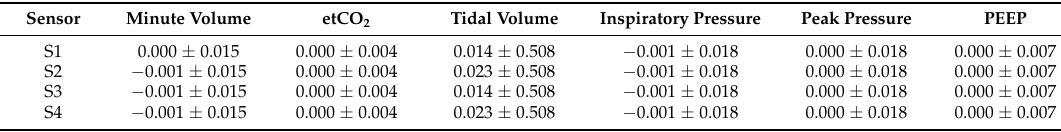
Table 4. Fixed effects regression coefficients of ventilation parameters vs. sensors after correction for ventilator settings and ETCO 2 Values indicate mean fixed effect regression coefficients ± their 95% confidence